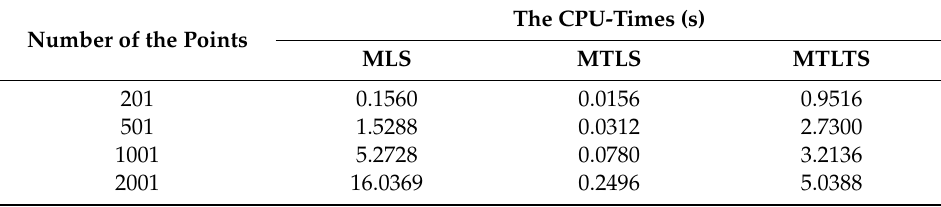
Figure 7. The trend of the s values.